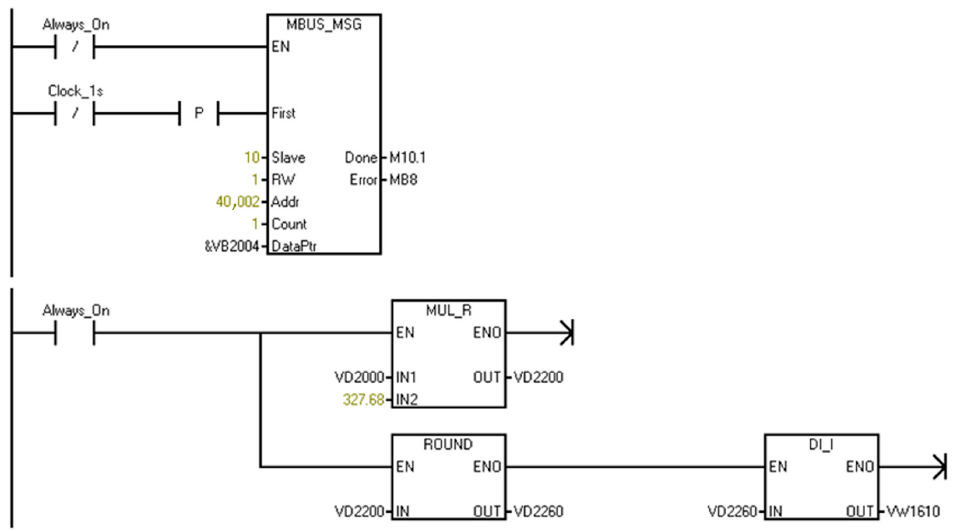
Figure 10. PLC Figure 10. PLC program.